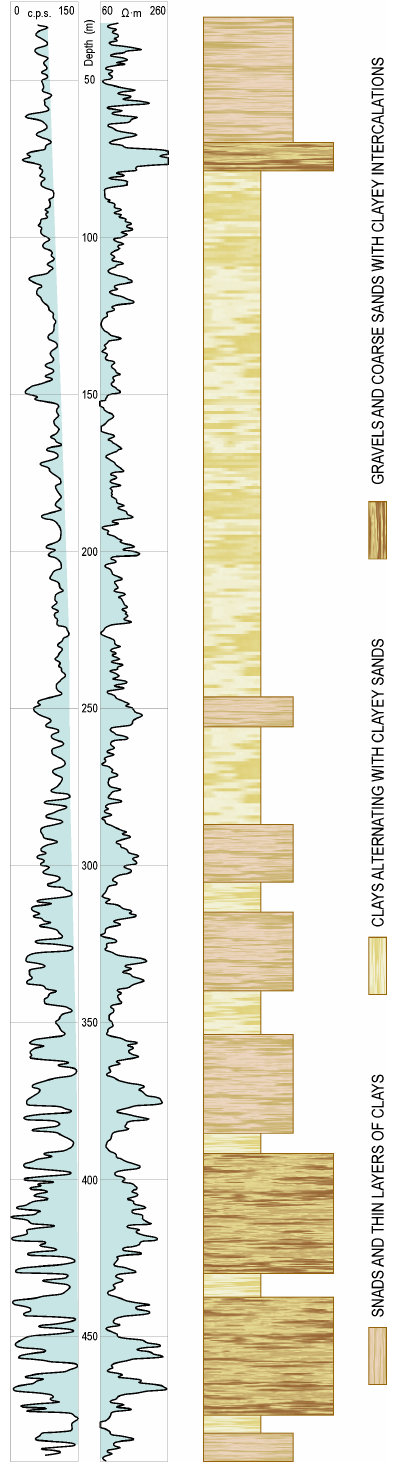
Figure 5. Well logs in the CNC borehole together with the lithologic section.